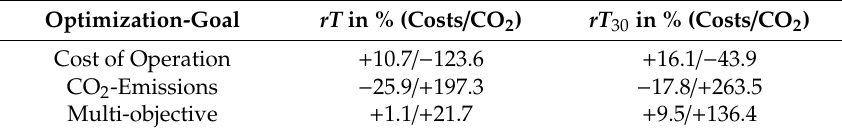
Table 3. Optimization results of scenario #1 in comparison to the results with standard